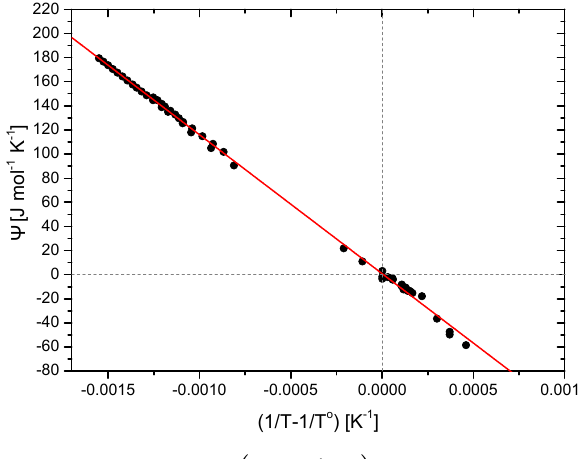
Figure A1. Partial pressures of PEG4 vs. PEG4 activity deduced from evaporation rates of single levitated, aqueous PEG4 particles in the EDB setup of Union College at a temperature of 286.5K. Black symbols: experiment data; red line and shaded area: linear fit to these data with the 95% confidence interval. Extrapolation to a PEG equal to 1 yields the saturation vapor pressure at this temper- ature, i.e., p 0 = ( 5 . 69 ± 0 . 55 ) × 10 − 3 Pa at this temperature.